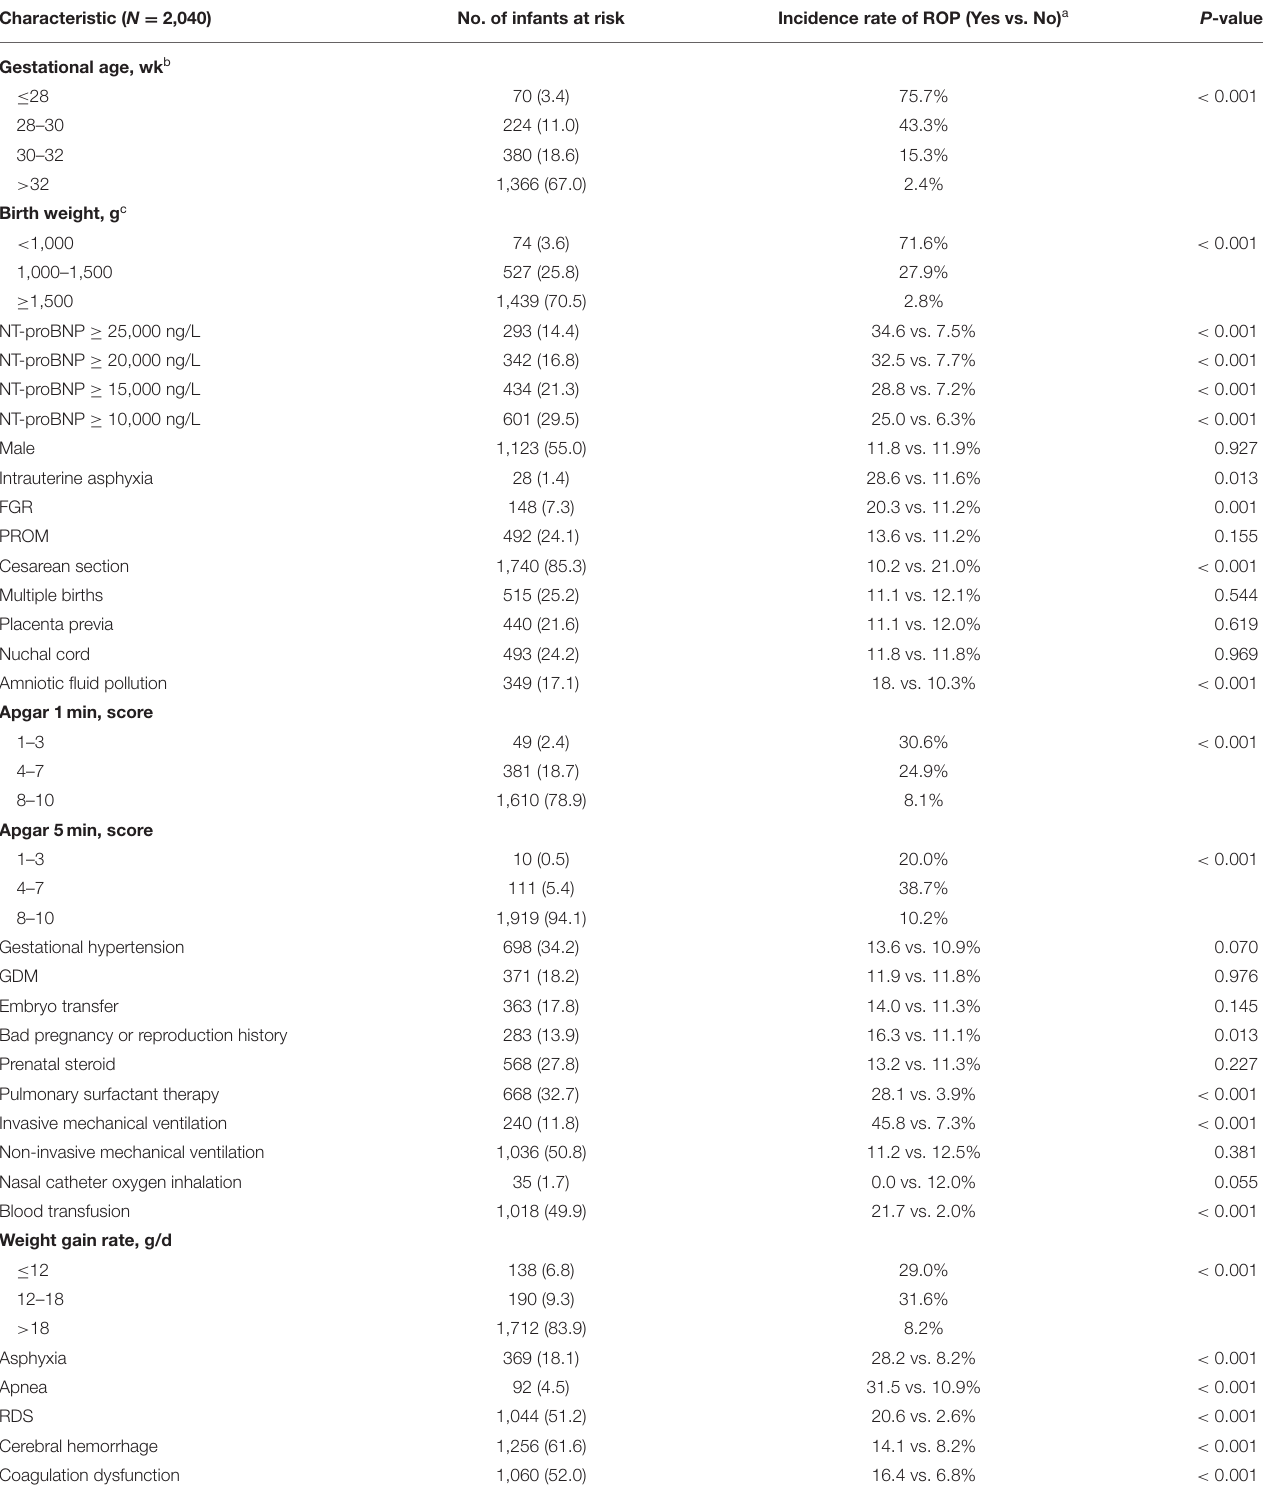
TABLE 1 | Characteristics of the 2,040 premature infants included in the